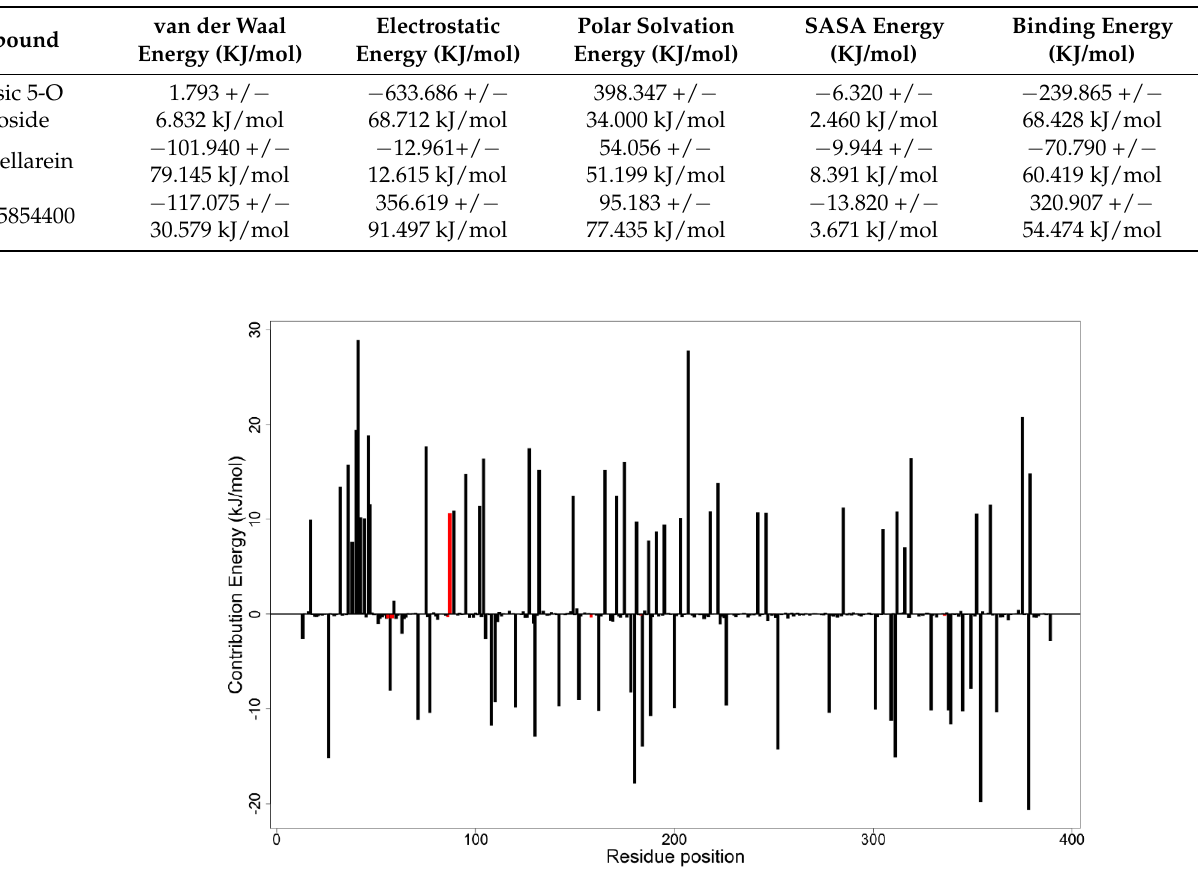
Figure 11. MM-PBSA plot of ZINC05854400 complex showing binding free energy contribution per-residue.